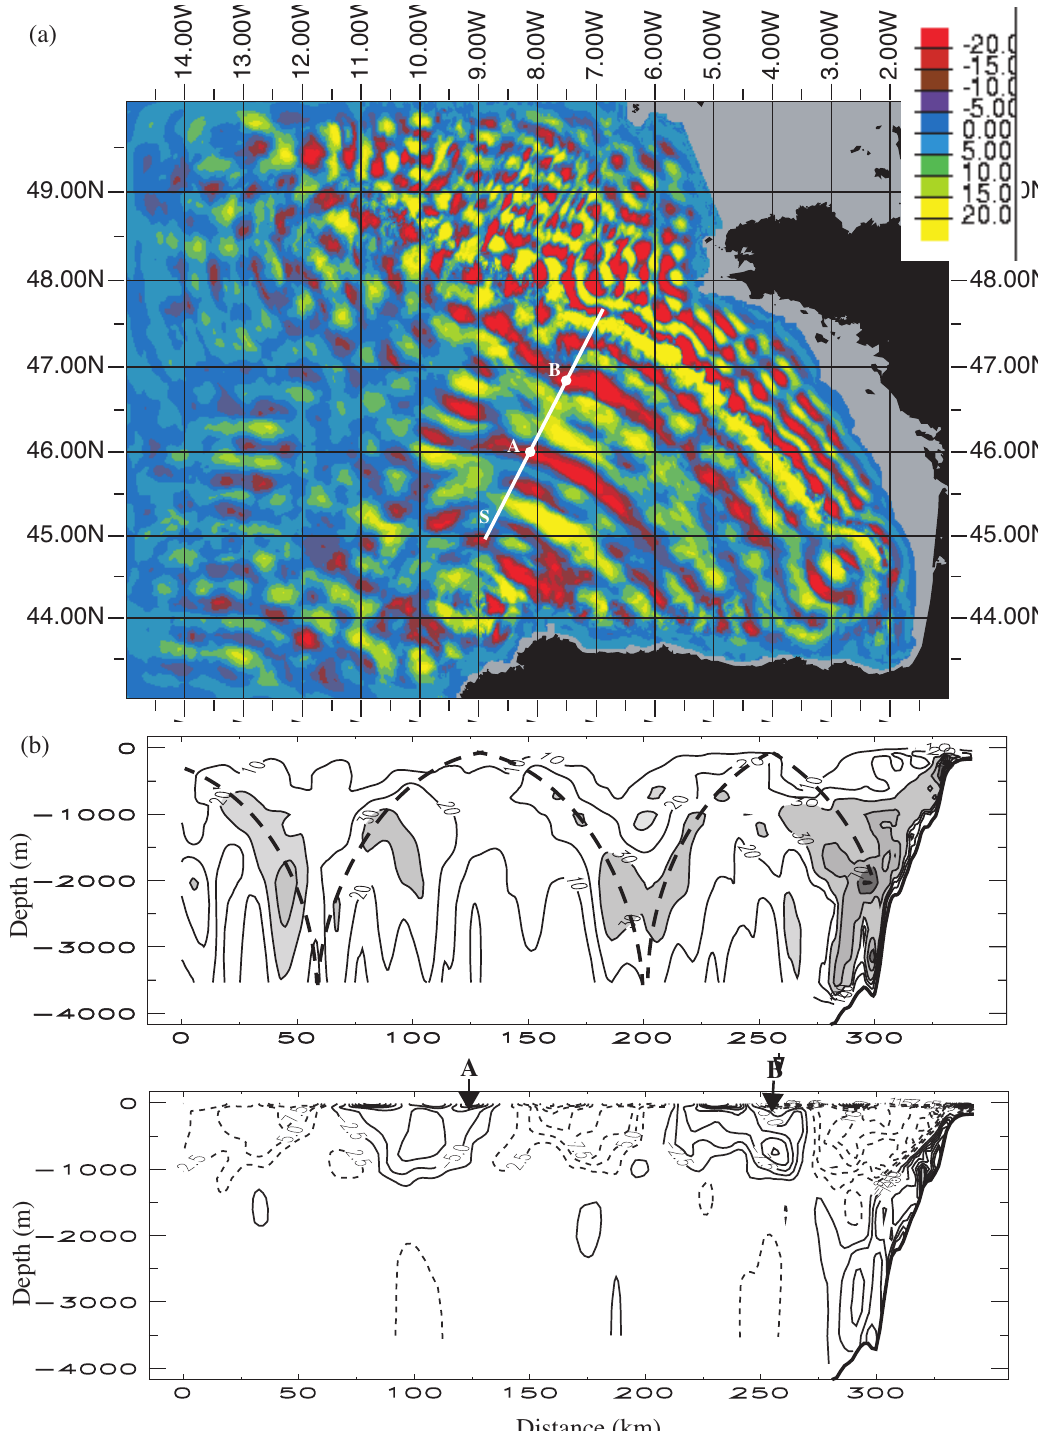
Distance (km) F IG . 7. – (a) Modelled east-west surface baroclinic velocity in September on 09/09 at 19 h (after the spring tide). Over the abyssal plain, veloc- ity varies from –20 cm s -1 (red) to +20 cm s -1 (yellow). Over the continental shelf, maximum values reach +/- 50 cm s -1 at different areas (around 7°W 48°N and 5.5°W 47.25°N); 50 km from the shelf break maximum values of the baroclinic current reach +/-30 cm s -1 . (b) Distribution of the internal tide amplitude along section S from 8.9°W 45.0°N to 6.9°W 47.6°N. The amplitude is the Fourier coefficient of the model result at the mean frequency of the four tidal waves, calculated over five tidal cycles. The bold dashed lines represent the paths of the characteristic rays. (c) Evolution of the total across-slope velocity along section S on 09/09 at 19 h. The angle between the normal to the bottom slope and the north is 25 ° . Dotted lines are negative values, dashed lines are positive